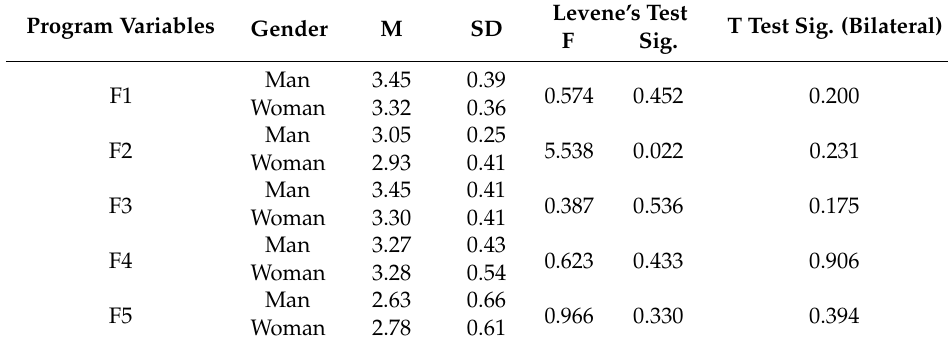
Table 2. Characteristics of the sample—resilience—regarding gender prior to intervention. Program Variables Gender M SD